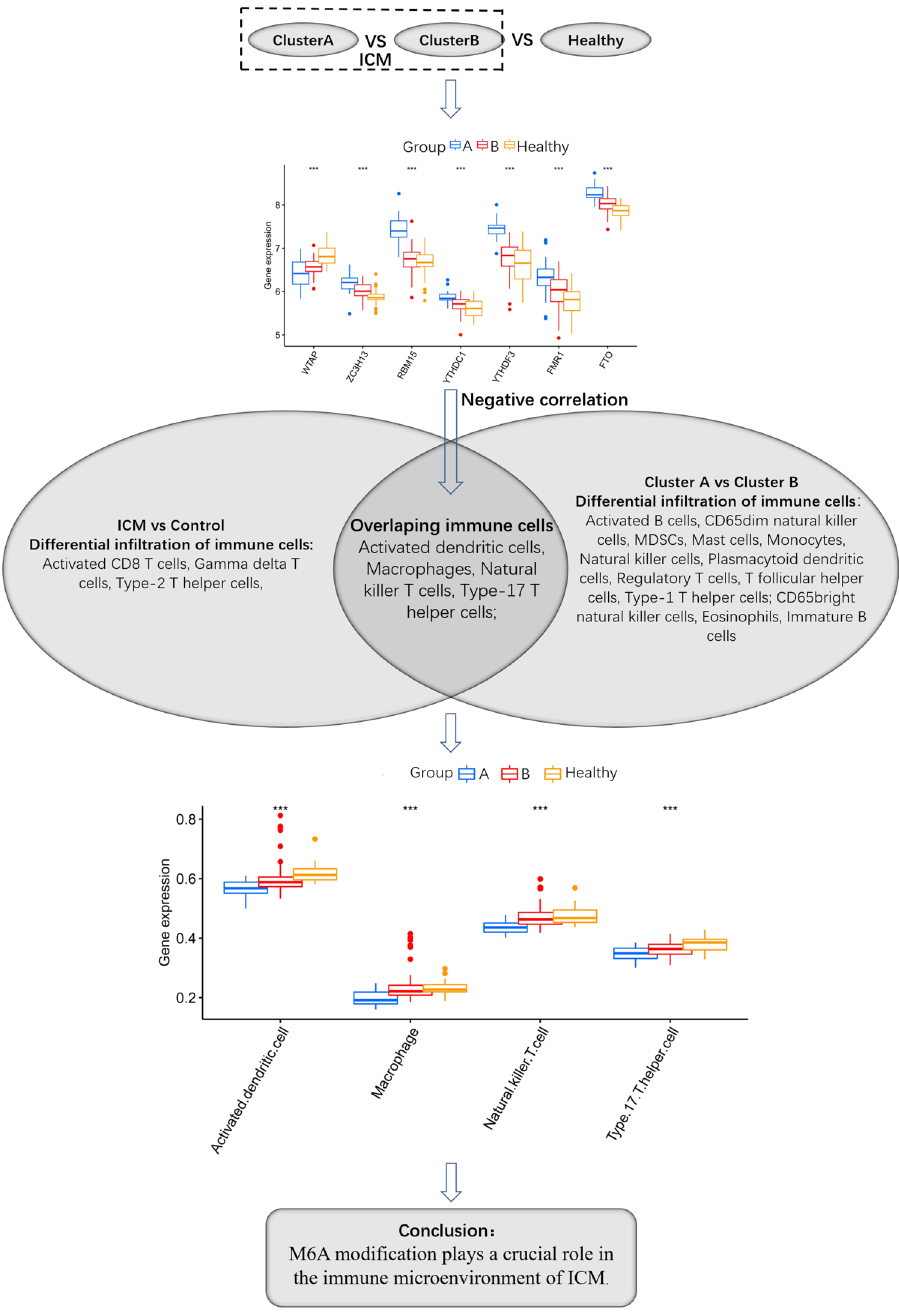
Figure 9. The summary diagram. *** P <